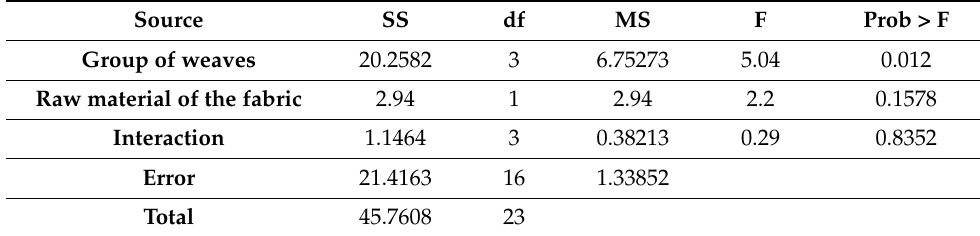
Table 3. ANOVA results for shrinkage in the weft